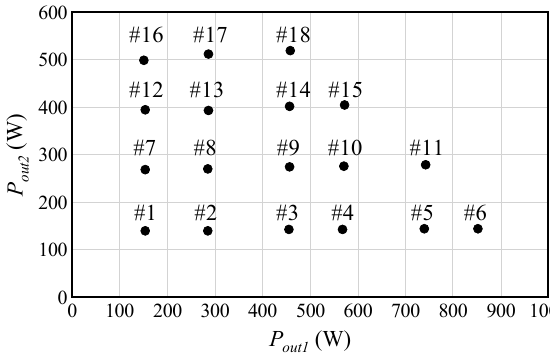
Figure 8. Measured operation points.